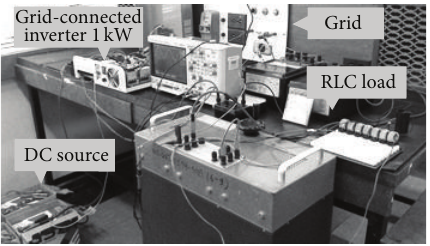
Figure 9: Experiment in research and developing of power elec- tronic laboratory.